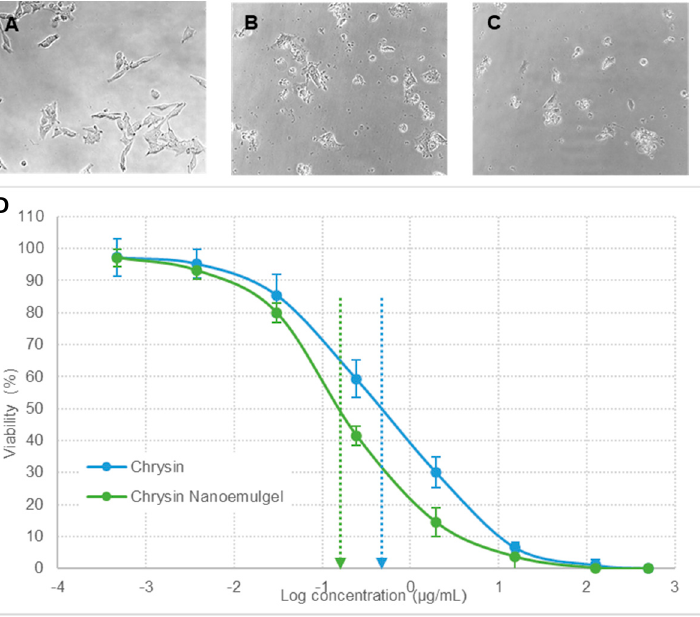
Figure 7. Morphological observation and growth inhibition of SK-MEL-2 cells. ( A ) control cells (untreated), ( B ) cells treated with pure chrysin, and ( C ) cells treated with chrysin nanoemulgel. Figure ( D ) represents the in vitro cytotoxicity profile, plotted as the viability of cells (%) versus the log of chrysin concentration ( μ g/mL). The data represented are mean values of 3 independent determinations, and error bars indicate standard error of triplicate analysis.